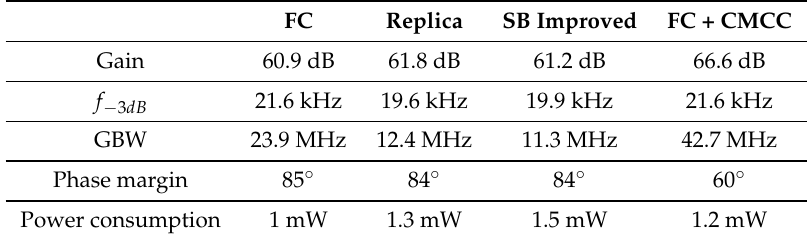
Table 3. AC and DC characteristics of the folded cascode (FC) amplifiers. FC